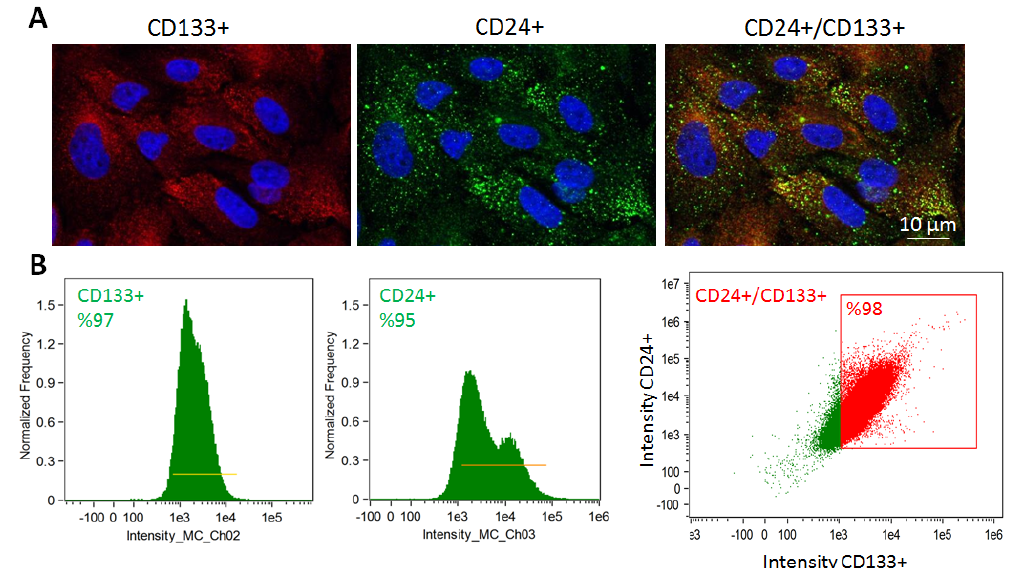
Figure 1. Characterization of Scattered tubular-like cells (STCs) isolated from pig kidneys. ( A ) Representative immunofluorescence staining (original magnification 40 X ) for the STC surface markers CD133 (red) and CD24 (green) in isolated swine STCs. ( B ) Flow cytometry analysis of isolated STCs showing that 97% of cells expressed CD133, 95% CD24, and 98% were double-positive for CD133 and CD24 ( n = 3 each).